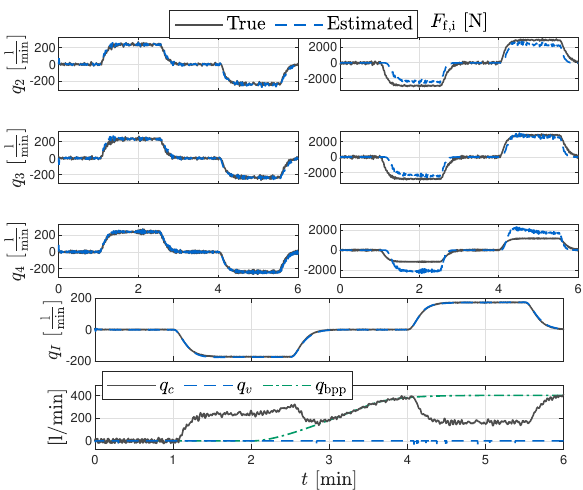
Figure 5: RIH flow rates, and wellbore friction force